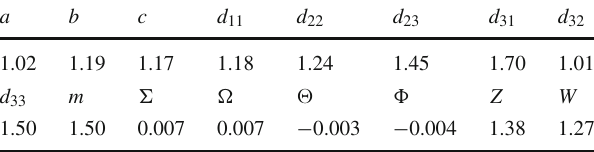
Table 3 Set of parameter assignments which lead to the final baryon asymmetry value shown in Fig. 3. The parameters are selected close to 1 as to avoid particular effects of enhancement or suppression in the ε i